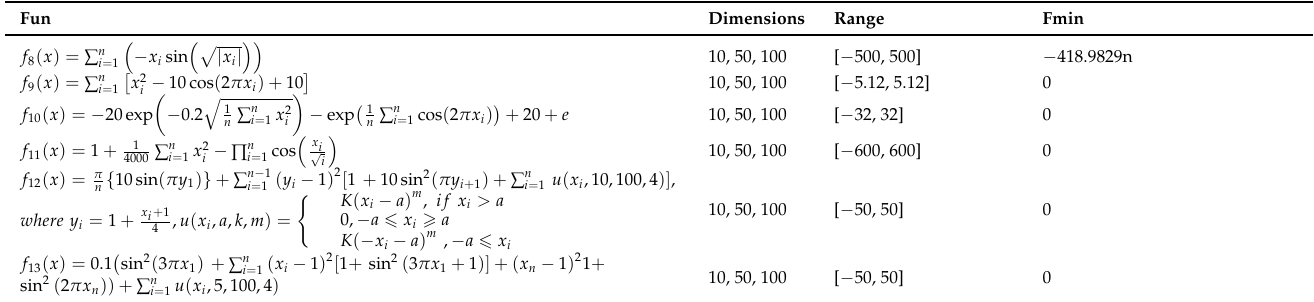
Table 3. Multimodal benchmark functions.